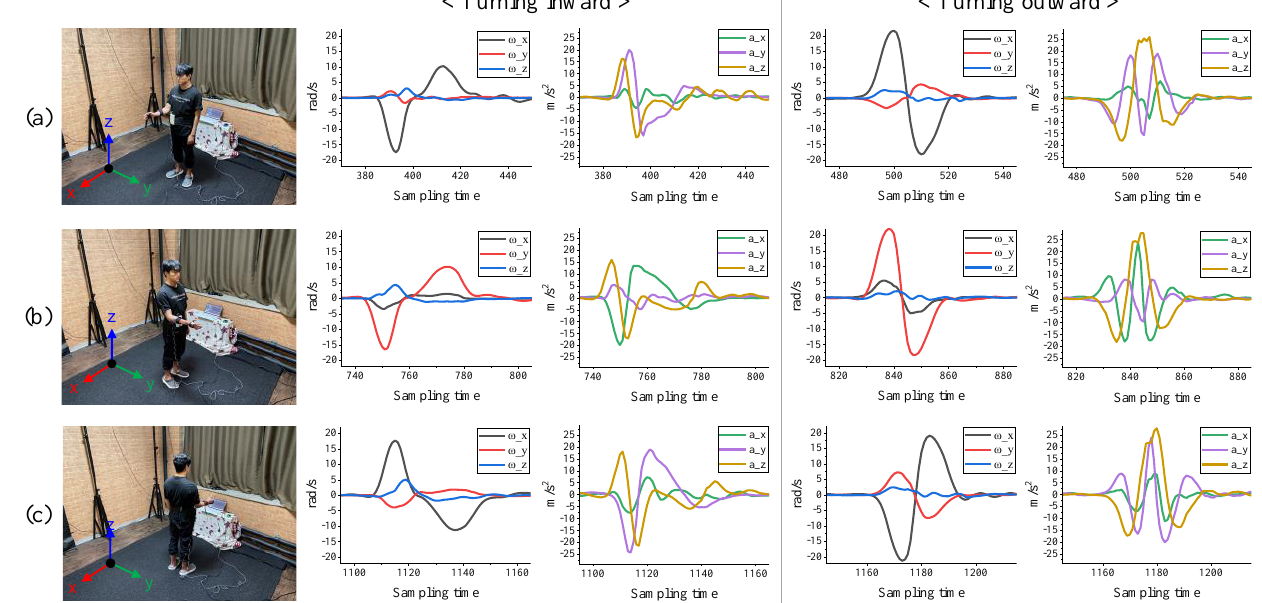
Figure 3. Comparison of angular velocity and acceleration of the back of the hand measured while simple handshaking in three different body-heading directions according to rotation about the z -axis: ( a ) initial body alignment, ( b ) 90 degrees, and ( c ) 180 degrees.